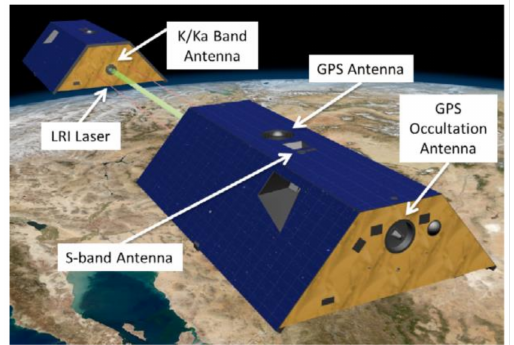
Figure 1. Appearance and instrument installation position of GRACE-FO